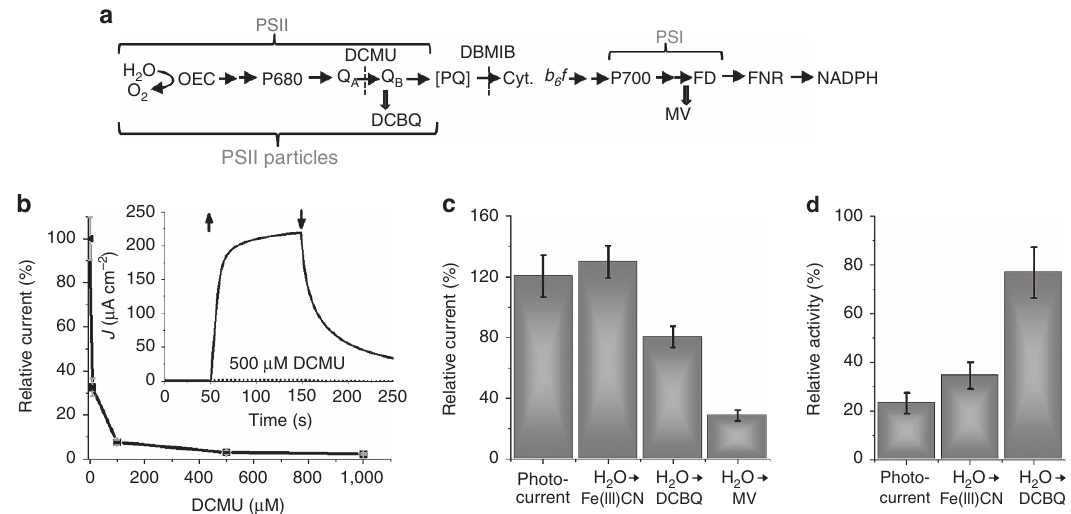
Figure 4 | The photosynthetic electrons are extracted by Fe(III)CN following the Q B site. ( a ) A scheme of the photosynthetic electron flow (horizontal arrows) with exogenous electron acceptors (vertical arrows) and electron flow inhibitors (vertical dashed lines). Double arrows mark additional electron acceptors. ( b ) Relative photocurrent of thylakoids, measured at a potential of 0.5V Ag/AgCl with 3mM Fe(III)CN, as a function of DCMU concentration, averaged over at least three experiments. The relative photocurrent is the photocurrent measured with DCMU divided by the photocurrent measured without it, as shown in the inset. ( c ) Relative photoactivity measured with DBMIB (5 m M) with respect to measurements without DBMIB. The columns show (left to right) the relative photocurrent and oxygen evolution rates measured with Fe(III)CN or DCBQ as acceptors and the oxygen consumption rate using MV as electron acceptor. The results error bars represent the s.d. over at least three measurements. ( d ) Relative photocurrent and photoactivity of Fe(III)CN and DCBQ reduction rates in PSII particles, relative to the respective measurements with intact thylakoids (both at the equivalent amount of 0.1mgChl). It is noted that when measured at the equivalent amount of lower chlorophyll concentration such as 0.01mgChl, the H 2 O to DCBQ activity of the PSII particles was higher than that of intact thylakoids. The error bars represent the s.d. over at least three measurements.